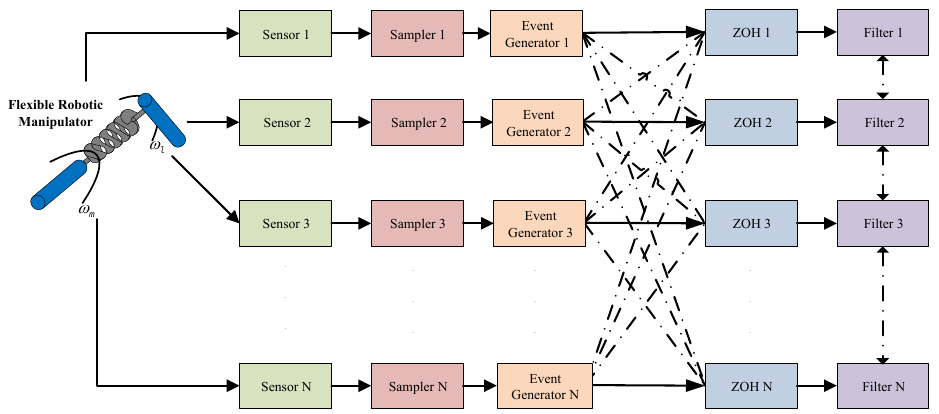
Figure 1. Illustration of distributed filtering on sensor